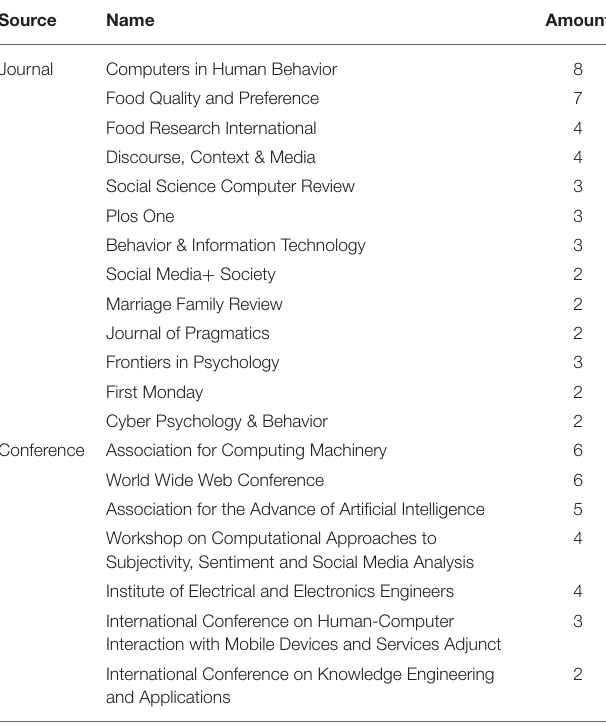
TABLE 1 | Statistics for articles on emoji published in journals and delivered at conferences.